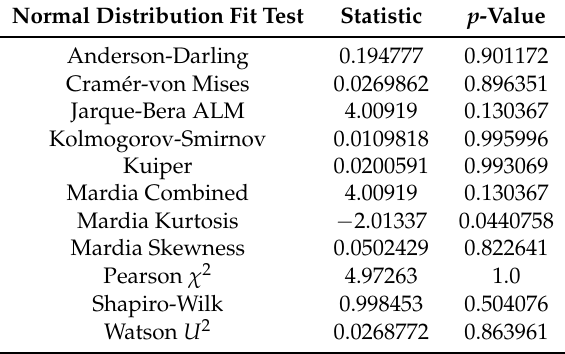
Table 2. p -tests values for a 3 Rotations model depicted in Figure 3, where n = 17 and Rot 2 been